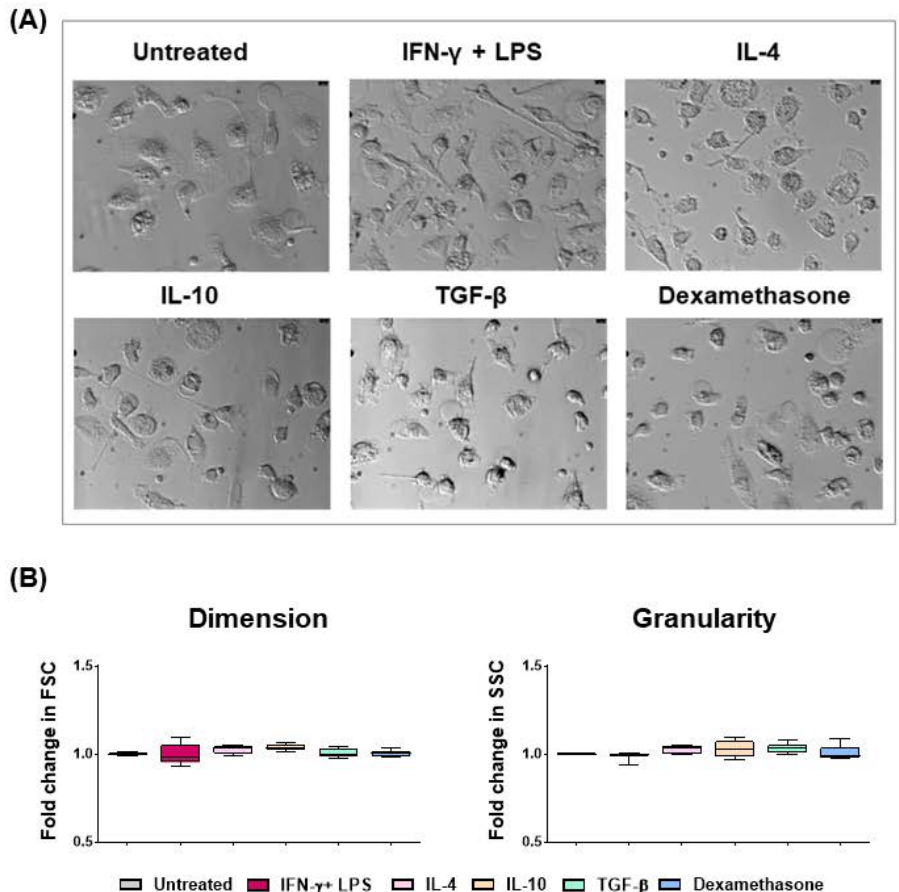
Figure 1. Porcine monocyte-derived macrophage subsets morphology. Porcine moM Φ were left untreated, or they were stimulated with diverse polarizing factors: IFN- γ + LPS (both at 100 ng/mL), IL-4 (20 ng/mL), IL-10 (20 ng/mL), TGF- β (20 ng/mL), or dexamethasone (20 ng/mL). Then, 24 h post-stimulation, morphologies were evaluated using phase contrast or fluorescence microscopy, as well as flow cytometry: ( A ) Phase contrast microscopy images were acquired using an inverted microscope, with a magnification 20 × . Scale bar, 10 µ m. Images of six representative macrophage subsets, one from each condition (untreated, IFN- + LPS, IL-4, IL-10, TGF- β , and dexamethasone) are presented; ( B ) flow cytometry was employed to evaluate changes in the dimension and granularity of moM Φ . Forward scatter (FSC) and side scatter (SSC) data are presented as fold change relative to the untreated control (moM Φ ). Mean data for quadruplicate biological replicates and standard deviation (SD) are presented. Values of treated macrophages were compared to the untreated control (moM Φ ), using an unpaired t -test of a Mann–Whitney